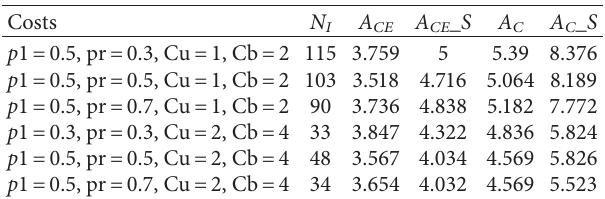
Figure 13: The digital level of enterprises under different environmental policies when R � 60: (a) pr � 0.3, Cu � 1, Cb � 2; (b) pr � 0.5, Cu � 1, Cb � 2; (c) pr � 0.7, Cu � 1, Cb � 2; (d) pr � 0.3, Cu � 2, Cb � 4; (e) pr � 0.5, Cu � 2, Cb � 4; (f) pr � 0.7, Cu � 2, Cb � 4. Table 4: The partial indicators of cooperative innovation network under different environmental